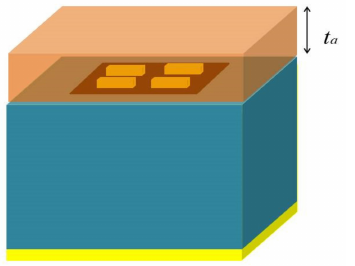
Figure 8. Proposed sensors with analyte thickness of t a .